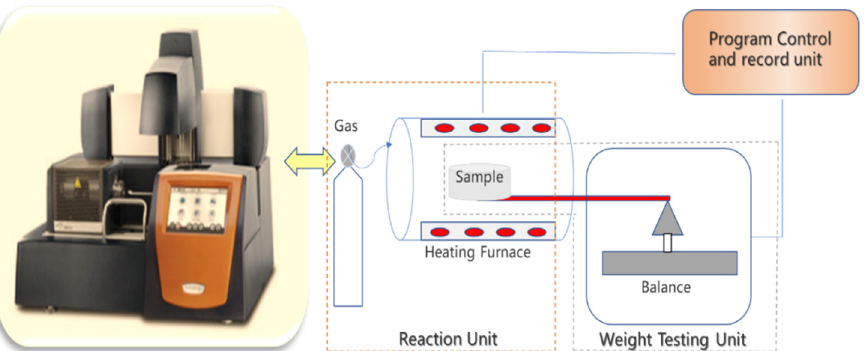
Figure 13. Synchronous thermal analyzer (TA Discovery SDT